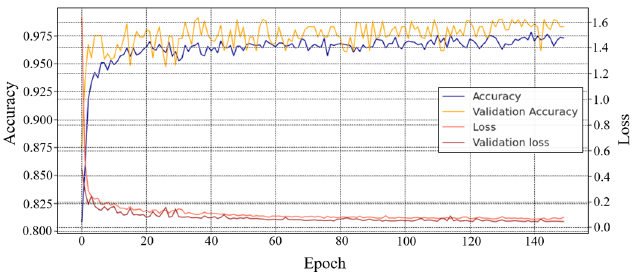
Figure 19. Training process of the 1D-CNN model.